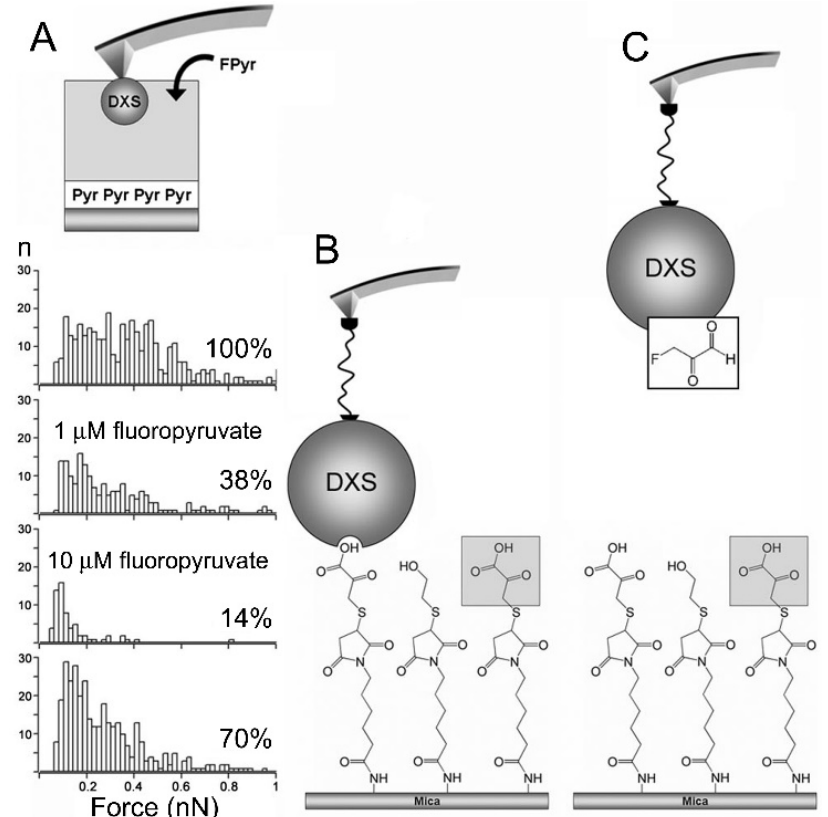
Figure 7. High-sensitivity, single-molecule nanosensor for the detection of DXS inhibitors. ( A ) Single-molecule force spectroscopy analysis of the effect of soluble fluoropyruvate on the binding between immobilized DXS and pyruvate. Temporal sequence from top to bottom: no soluble fluoropyruvate, addition of 1 μ M fluoropyruvate, addition of 10 μ M fluoropyruvate, removal of soluble fluoropyruvate. ( B ) Configuration showing the interaction between DXS bound to a nanoscale sensor and pyruvate to mica surfaces. ( C ) A significant decrease in the binding of DXS to the pyruvate-functionalized surface indicated the presence of an inhibitor in solution. Reproduced with permission from [176], Federation of American Societies for Experimental Biology, 2010.